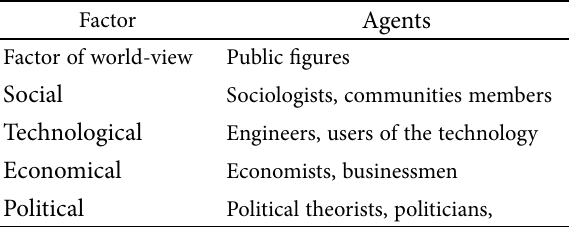
Table 3. Factors and agents of environmental protection 4